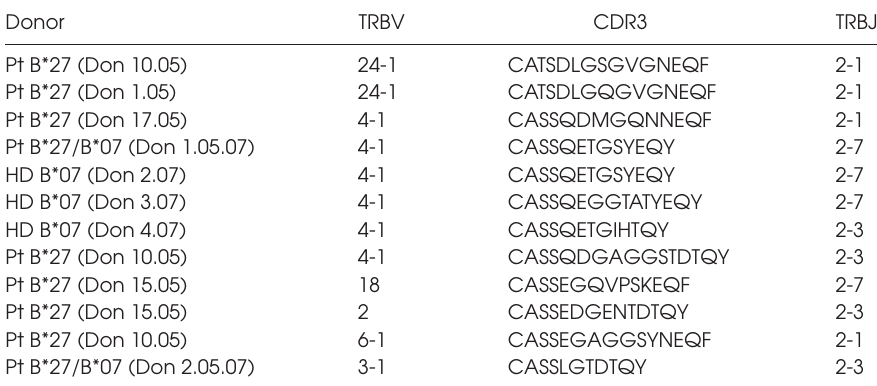
Table 1. TCR β -chain sequences of pEBNA3A-responsive CTL lines.